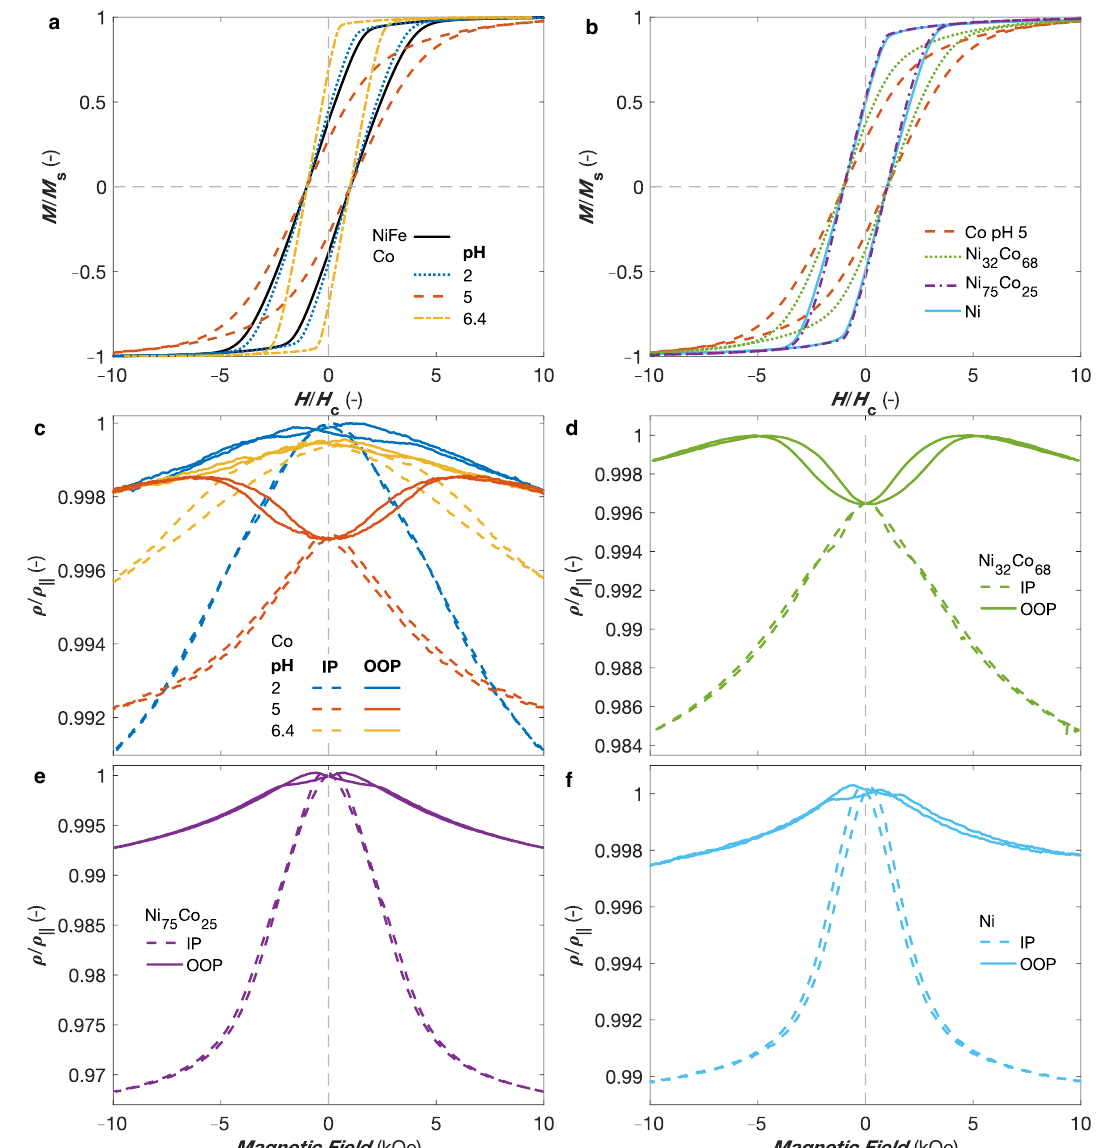
Figure 5. ( a , b ) Magnetisation curves as a function of the field ratio H / H c , where H c is the corresponding coercive field, recorded while sweeping the external magnetic field in the out-of-plane direction of interconnected nanowire networks with 40 nm in diameter and 20% in packing fraction made of ( a ) NiFe and Co electrodeposited using different electrolytic pH values of 2.0, 5.0, and 6.4 and ( b ) various Ni x Co 1 − x alloys, with 0 ≤ x ≤ 1. ( c , f ) Room temperature magnetoresistance curves obtained by applying the magnetic field in the out-of-plane (OOP; full lines) and in-plane (IP; dashed lines) directions for ( c ) the Co nanowire networks in panel ( a ), as well as the ( d ) Ni 32 Co 68 , ( e ) Ni 75 Co 25 , and ( f ) Ni crossed nanowire networks in panel ( b